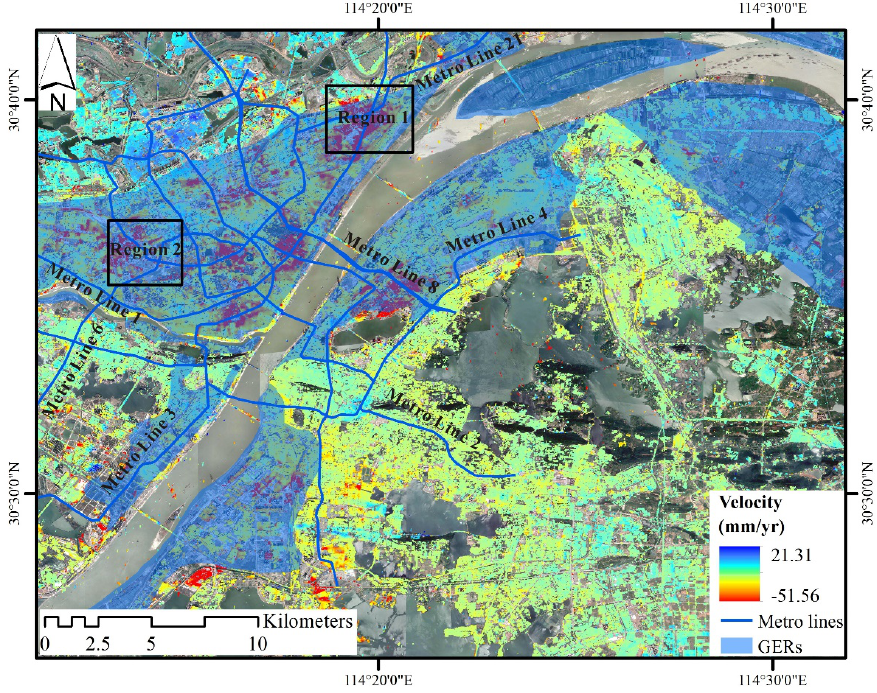
Figure 9. Map of the GERs and Metro Networks of Wuhan city.